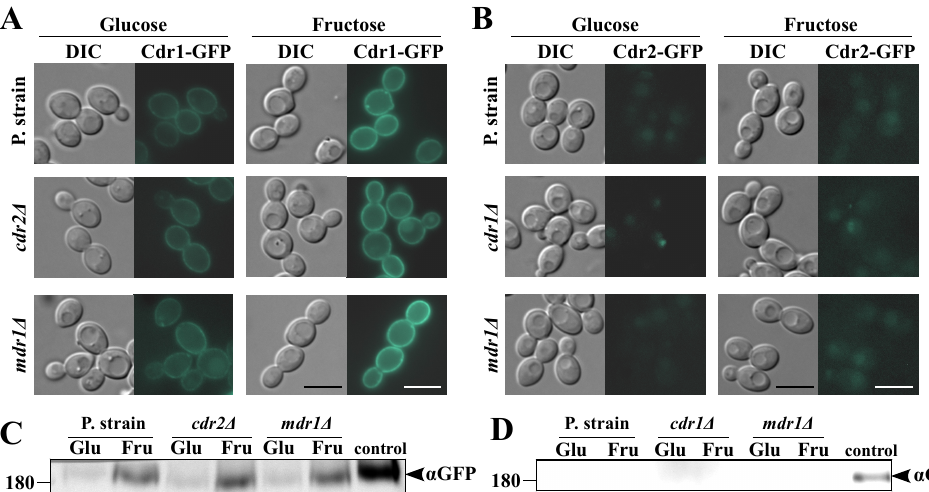
Figure 3. Fluorescence micrographs of the subcellular localization of the ( A ) Cdr1p-green fluorescent protein (GFP) in the C. albicans strains, KS052 (CAF2-1 CDR1-GFP ), KS053 (DSY653 CDR1-GFP ), and KS054 (DSY465 CDR1-GFP ) or ( B ) Cdr2p-GFP in the C. albicans strains KS063 (CAF2-1 CDR2-GFP ), KS064 (DSY448 CDR2-GFP ), and KS065 (DSY465 CDR2-GFP ). Scale bar = 5 µm. ( C ) Immunoblot analysis of Cdr1p-GFP in C. albicans KS052, KS053, and KS054. A positive control was prepared by treating the KS052 strain with 4-µg/mL FLC for 4 h. ( D ) Immunoblot analysis of Cdr2p-GFP in C. albicans KS063, KS064, and KS065. A positive control was prepared by treating the KS063 strain with 20-µg/mL fluphen- azine for 4 h. In all the presented experiments, the C. albicans strains were grown in yeast nitrogen base glucose (YNBG) or yeast nitrogen base fructose (YNBF) media for 8 h at 28 °C.